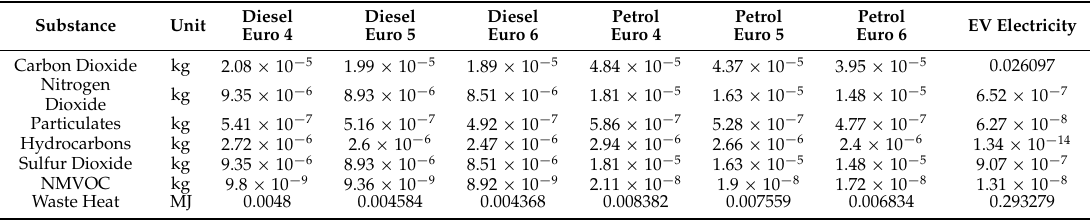
Table 9. Fuel refinery and electricity production related emissions. NMVOC: Non methane volatile organic